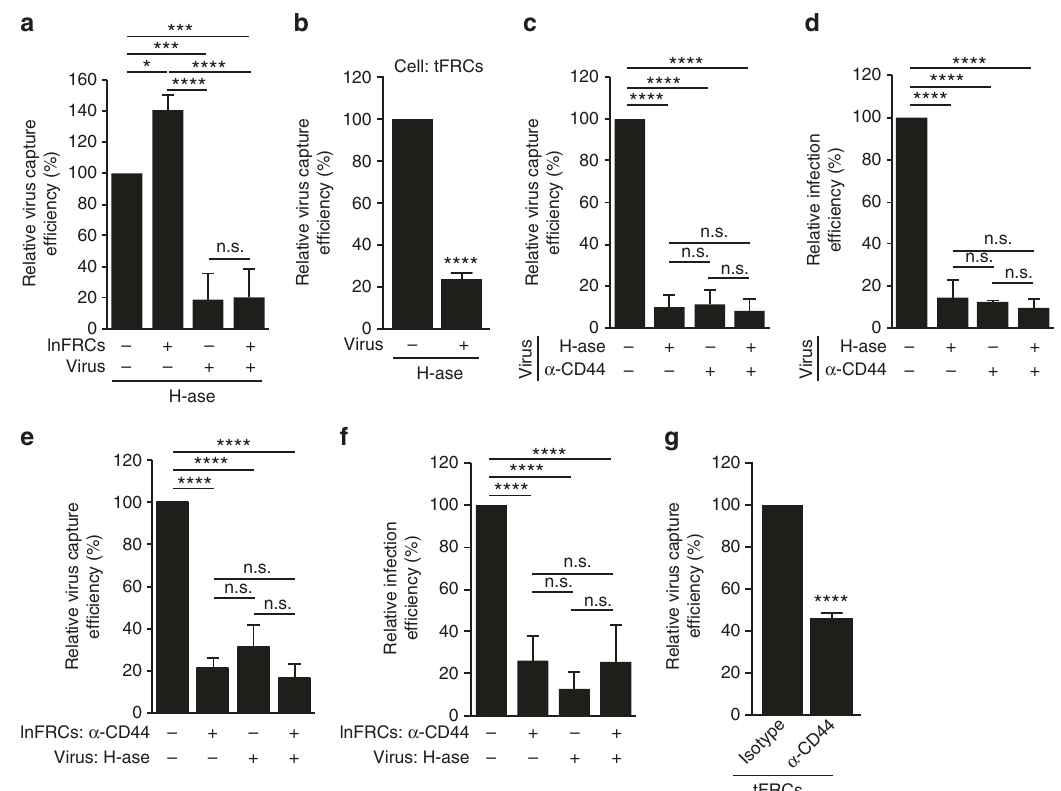
Fig. 7 Interactions between CD44 and HA promote FRC-mediated trans-infection. a HIV-1 generated in HeLa cells was either untreated or pretreated with 10 units/ml hyaluronidase (H-ase) for 1 h and used as an inoculum without separating virus from H-ase. lnFRCs were either untreated or pretreated with 10 units/ml H-ase for 1 h, and then H-ase was removed by washing with PBS twice prior to addition of the untreated or H-ase-treated virus inoculums. The amount of virus captured by lnFRCs was quanti fi ed by p24 ELISA assays. b tFRCs were cultured in the presence of HeLa-derived HIV-1 NL4-3 (100 ng p24), which were either untreated or pretreated with 25 units/ml H-ase, for 1 h. After 2-h incubation with the virus, cells were washed extensively, and the amount of virus captured by tFRCs was quanti fi ed by p24 ELISA assays. c , d HeLa-derived HIV-1 was pretreated with 10 units/ml H-ase and/or 0.625 μ g/ ml anti-CD44 antibody for 1 h and used as inoculums without separating virus from H-ase or anti-CD44. lnFRC-mediated virus capture and trans-infection to A3.01 T cells were examined as in Fig. 6c, d, respectively. e , f HeLa-derived HIV-1 was either untreated or pretreated with 10 units/ml H-ase for 1 h and used as inoculums. lnFRCs were either untreated or pretreated with 10 μ g/ml anti-CD44 antibody for 1 h, and excess antibodies were removed by washing with PBS twice prior to addition of the untreated or H-ase-treated virus inoculums. lnFRC-mediated capture of viruses and trans-infection to A3.01 T cells were examined as in Figure 6c, d, respectively. g tFRCs were pretreated with 10 μ g/ml anti-CD44 antibody for 1 h, and excess antibodies were removed by washing with PBS twice prior to addition of HeLa-derived HIV-1 NL4-3 (100 ng p24). Virus capture was examined as in b . For experiments in a , c – f , the data represent the mean ± SD of three ( a , c – e ) and four ( f ) independent experiments. These experiments were performed using lnFRCs from one donor, but we observed similar results by using lnFRCs isolated from two other donors (total three donors). For experiments shown in b and g , tFRCs from three different donors were used. The p- values were determined using Tukey ’ s test following one-way ANOVA for a , c – f and two-tailed Student ’ s t -test for b and g . * p